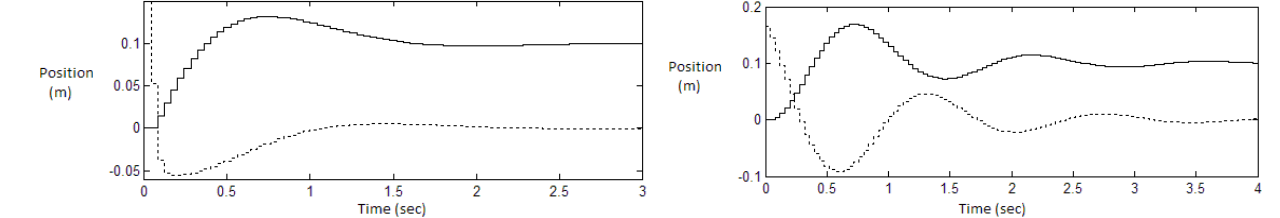
Figure 27: Step response of feedback‐linearized P‐D controller using filtered derivative Figure 26. Simulated discrete step response of the feedback-linearized PD controller using the filtered derivative. Both the linear and nonlinear feedback controllers were implemented on the test platform.